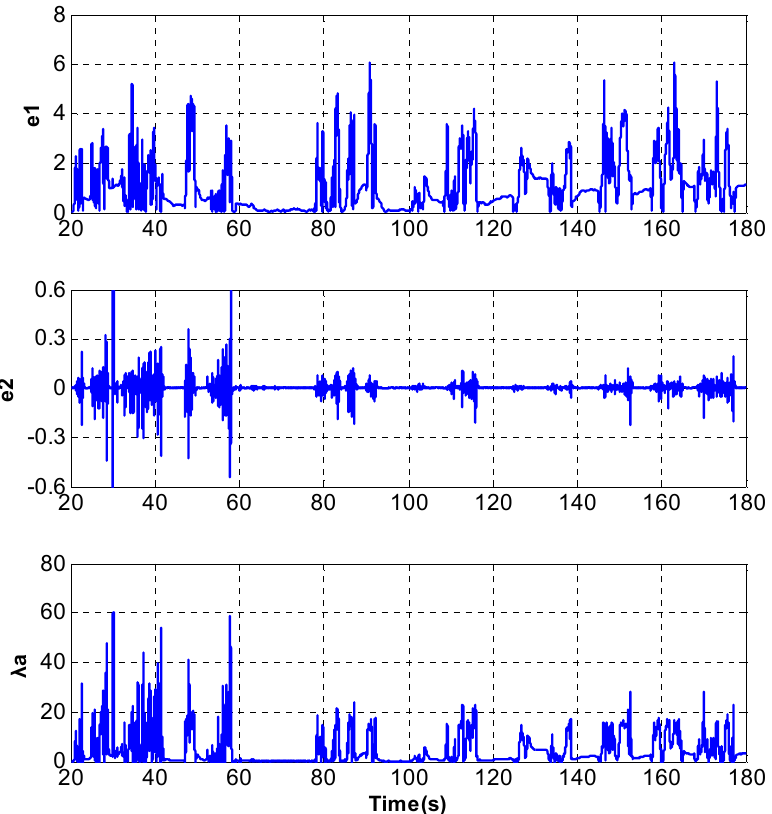
Figure 16. Fuzzy inputs e 1 and e 2 and fuzzy output λ a during flight.